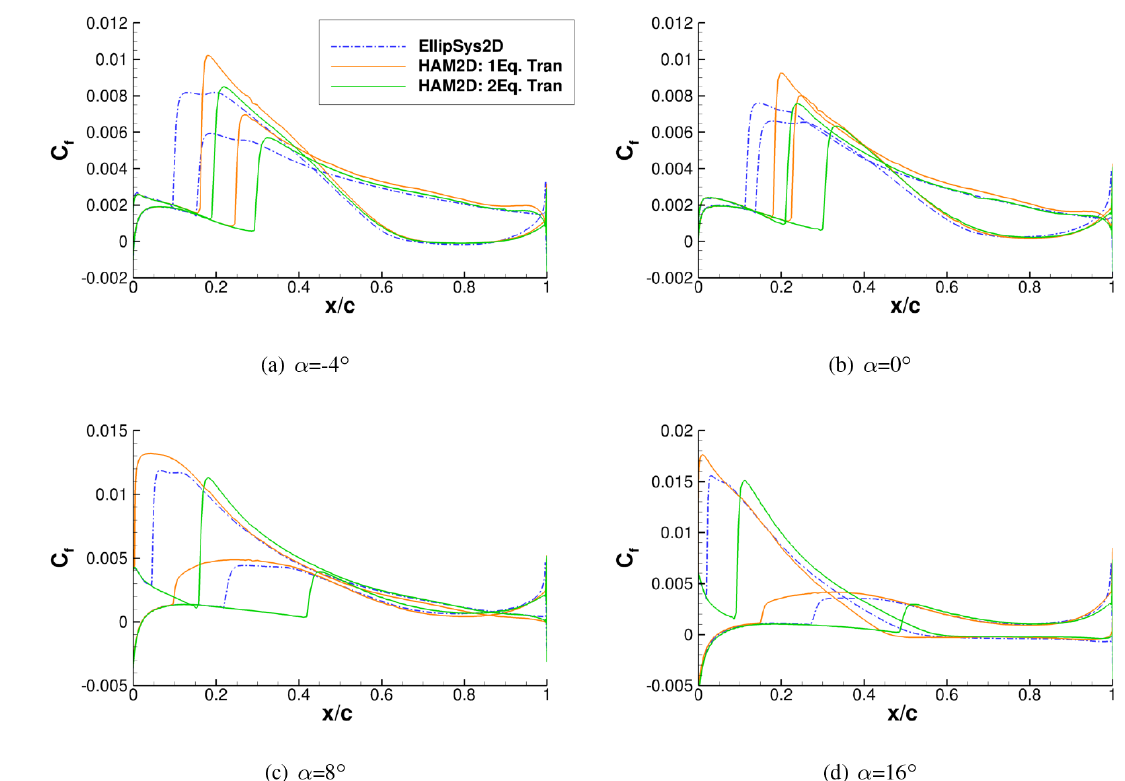
Figure 13. Skin friction coefficient distribution for the FFA-W3-301 airfoil at Re = 10 × 10 6 generated using HAM2D with the one-equation and two-equation transition models compared against EllipSys2D with the γ − Re θ t transition model (Bak et al.,